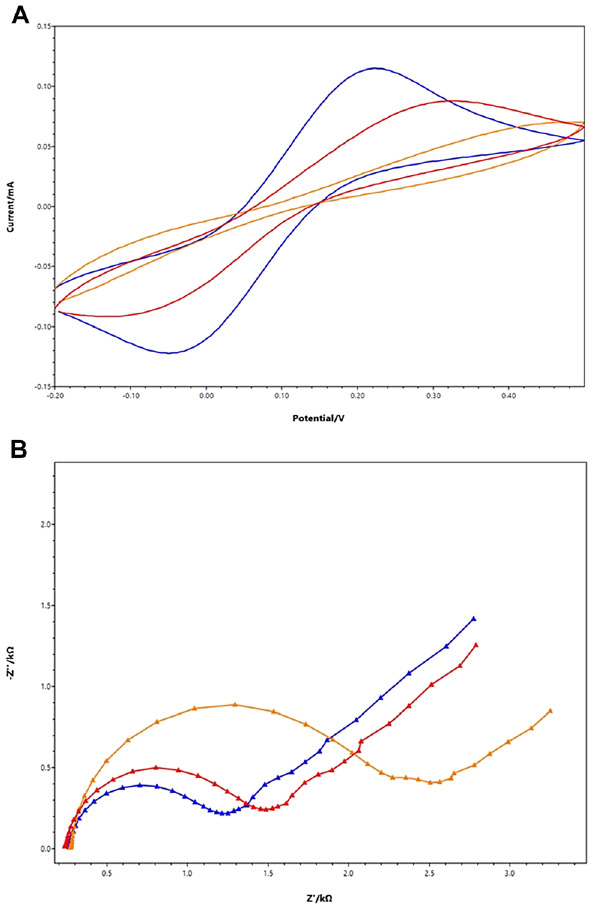
Figure 1: CV and EIS data showing the modification steps of the LNCaP biosensor. A. Representation of the CV data (Blue CV; GNPE, Red CV; GNPE-Apt, Orange CV; GNPE-Apt-LNCaP modifications) at different scan cycles. B. Representation of EIS data (Blue EIS; GNPE, Red EIS; GNPE-Apt, Orange EIS; GNPE-Apt-LNCaP (LNCaP: 10 cells/mL) at different scan